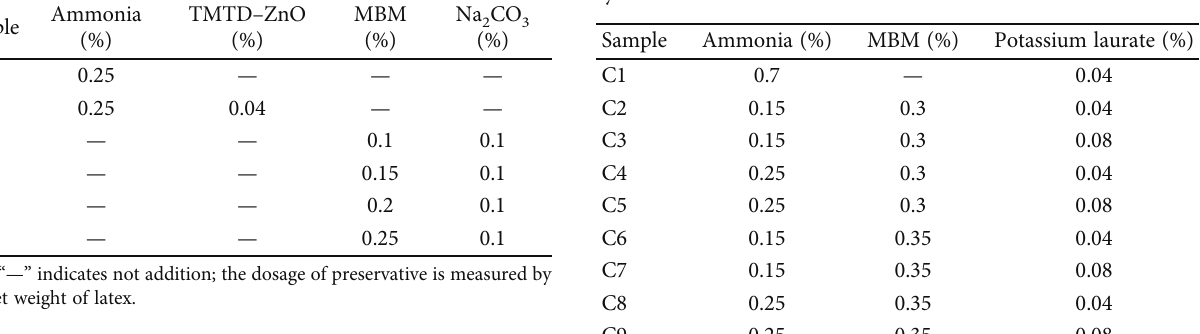
Table 2: Preservation formula of concentrated NRL. Sample